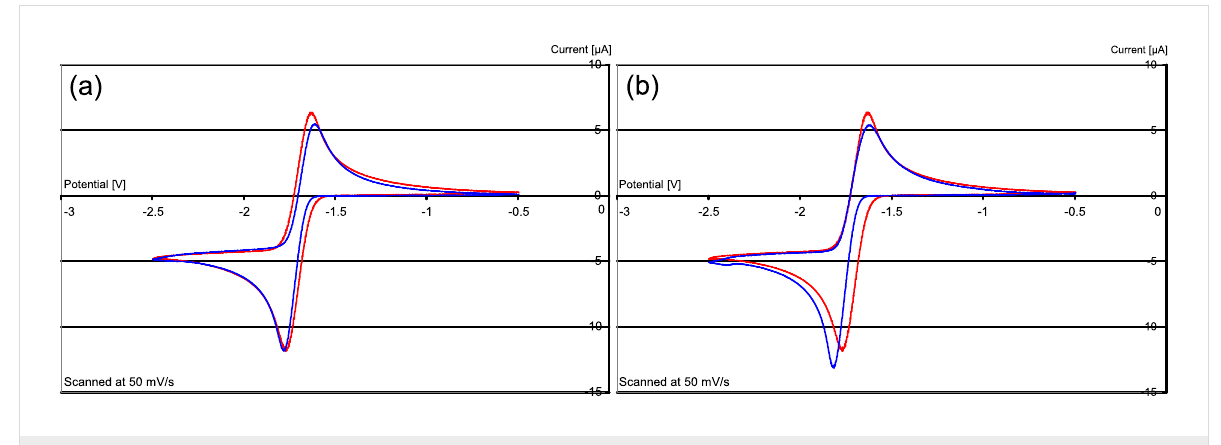
Figure 4: (a) Cyclic voltammograms vs. Fc/Fc + of 17 ′ ↔ 8 (red) and 18 ′ ↔ 15 (blue) and (b) of 17 ′ ↔ 8 (red) and 20 ′ ↔ 19 (blue).